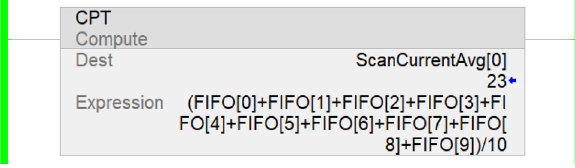
Fig. 19 The new scan time average of the modified